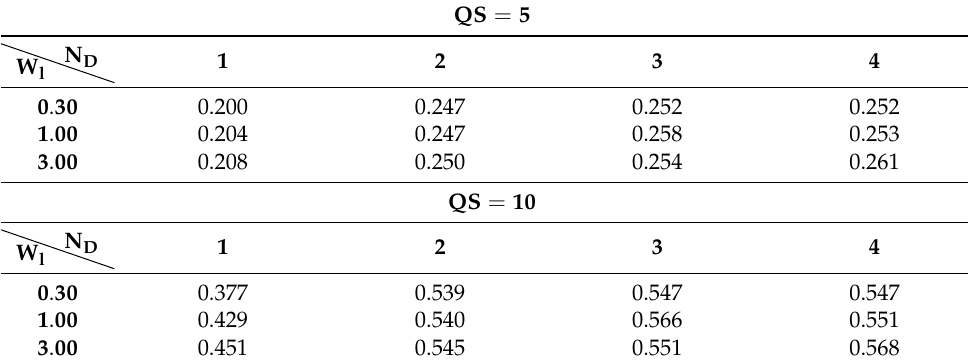
Table 7. Mean delay